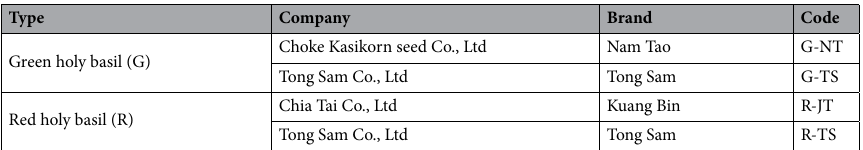
Experiment 1: KNO concentration selection. Seed priming treatment. Seeds were randomly drawn 3 from each variety and were primed with KNO 3 solution at four different concentrations: 0%, (KNO3 0 g L −1 )